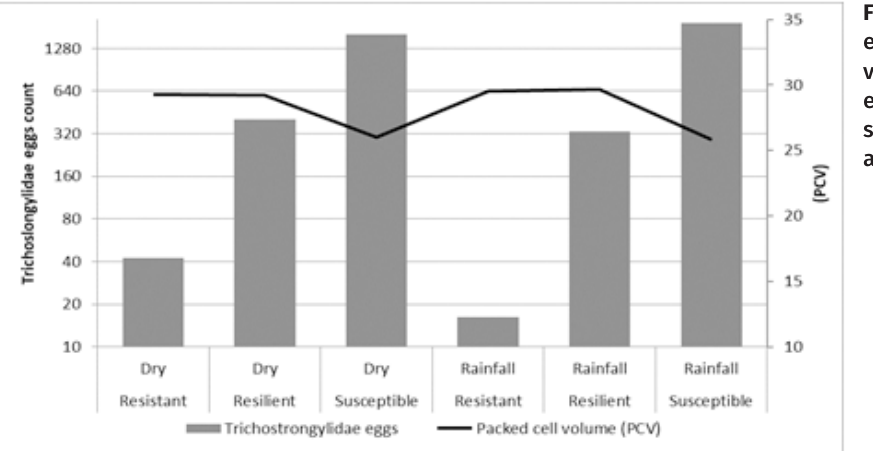
Figure 3 . Trichostrongylidae egg counts and packed cell volume of Morada Nova ewes resistant, resilient and susceptible during the dry and rainy seasons.